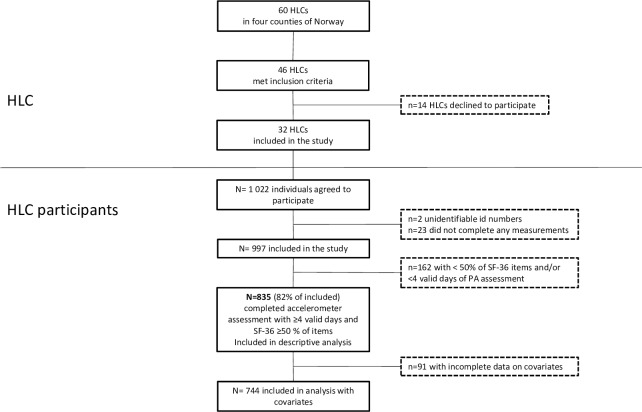
Flow of Healthy Life Centers (HLCs) and study participants.